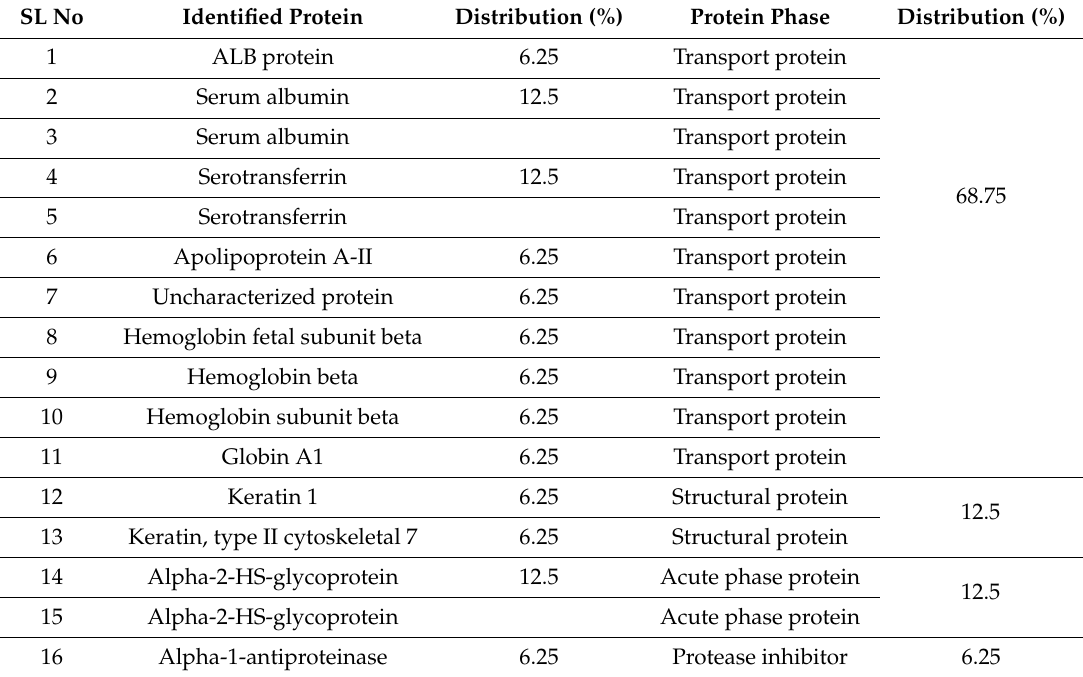
Table 10. Protein distribution (%) around α -KAMCA NPs in 10%